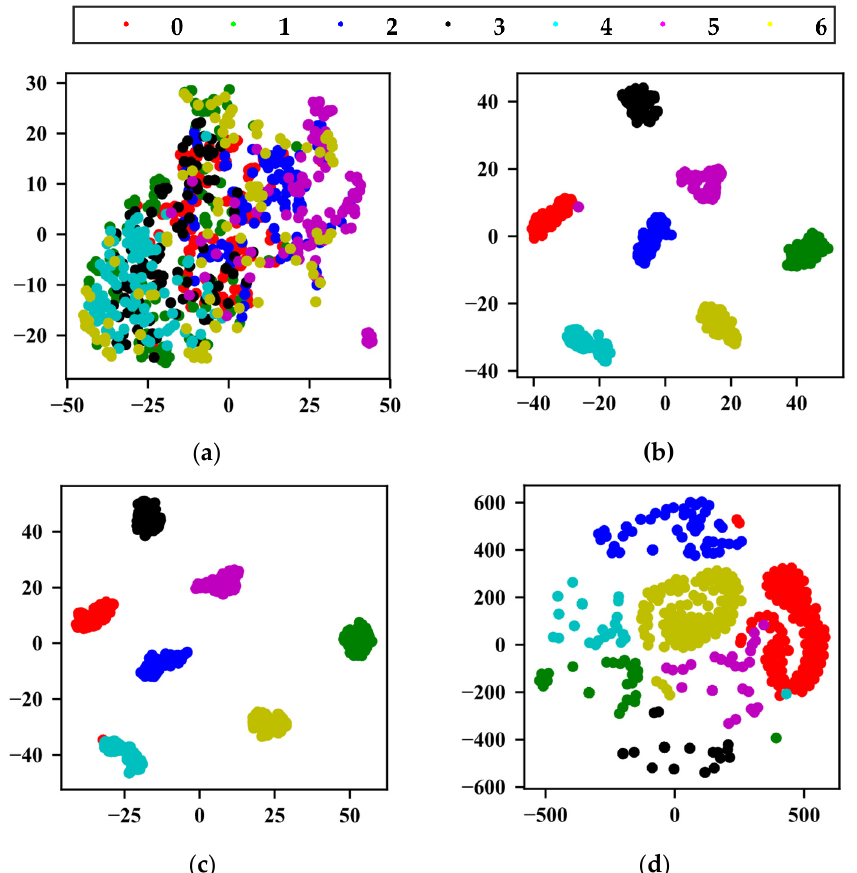
Figure 8. t-SNE dimensionality reduction feature visualization. ( a ) Original data, ( b ) method of this